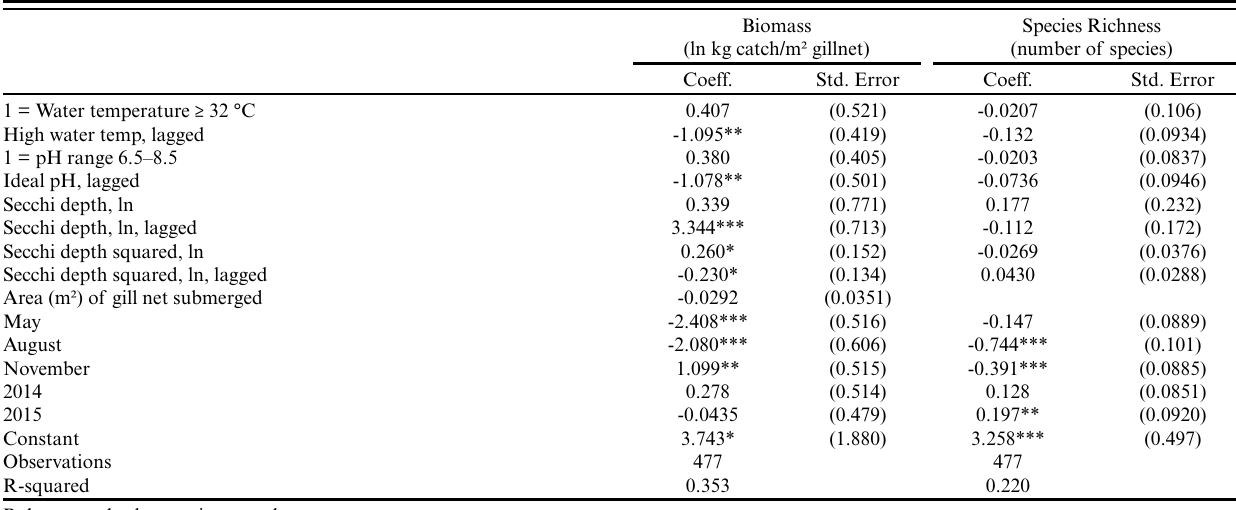
Table 2 . The relationship between water quality indicators and community fish refuge (CFR) biomass and biodiversity. Using longitudinal regression models that include fixed effects for the month, year, and CFR, we show relationships between the role of water quality characteristics in the current and previous periods (“lagged” values below) and biomass and species richness in CFRs. “ln” refers to the natural